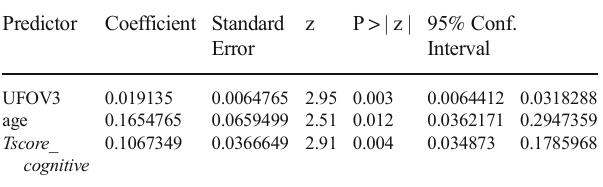
Coefficients for univariate logistic regression using UFOV3, age and Tscore _ cognitive Predictor Coefficient Standard z Error